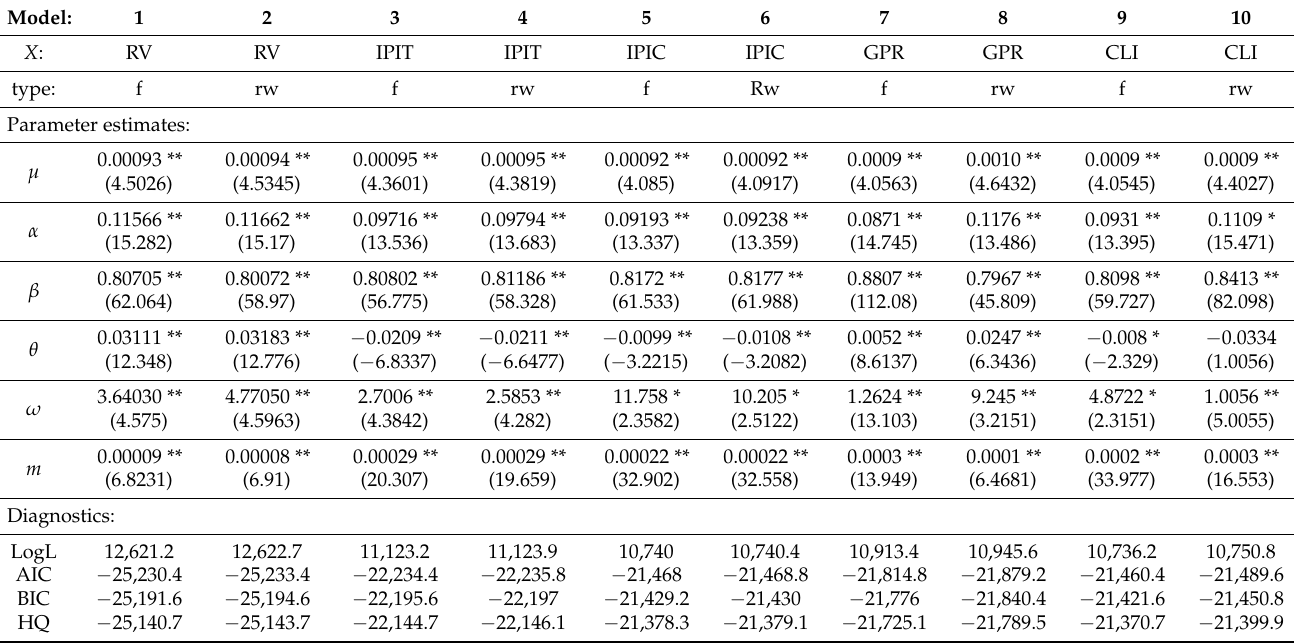
Table 4. GARCH-MIDAS Parameter Estimation